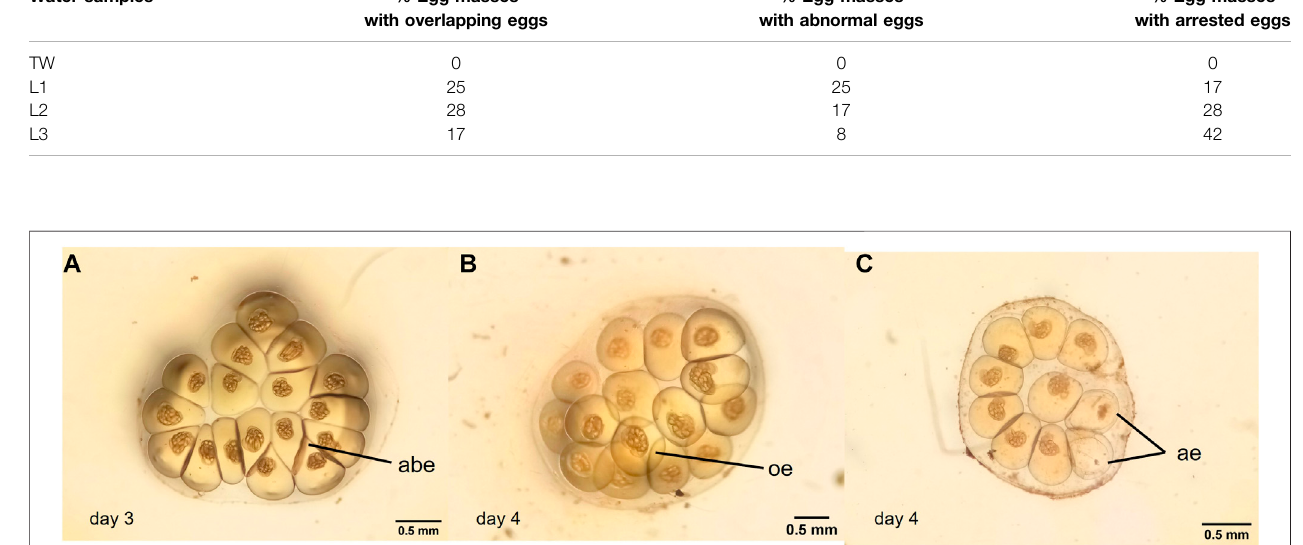
FIGURE 3 | Photographs of abnormal Biomphalaria straminea egg masses treated with different water samples from Lugano Lake. (A) : egg mass with abnormal eggs, (B) egg mass with overlapping eggs, (C) : egg mass with arrested eggs. abe: abnormal egg; oe: overlapping eggs; ae: arrested eggs.